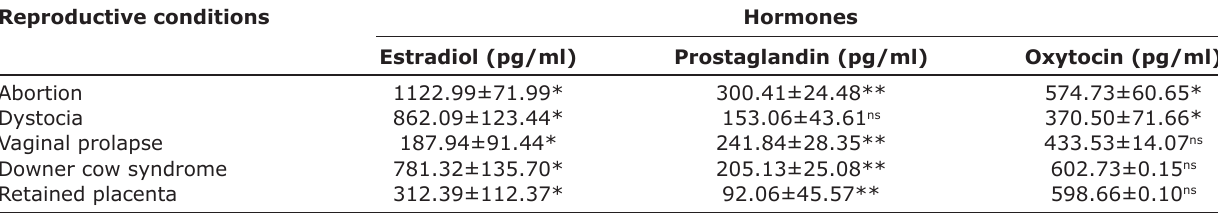
Table-1: Mean±standard deviation of hormones in cows with reproductive conditions. Reproductive